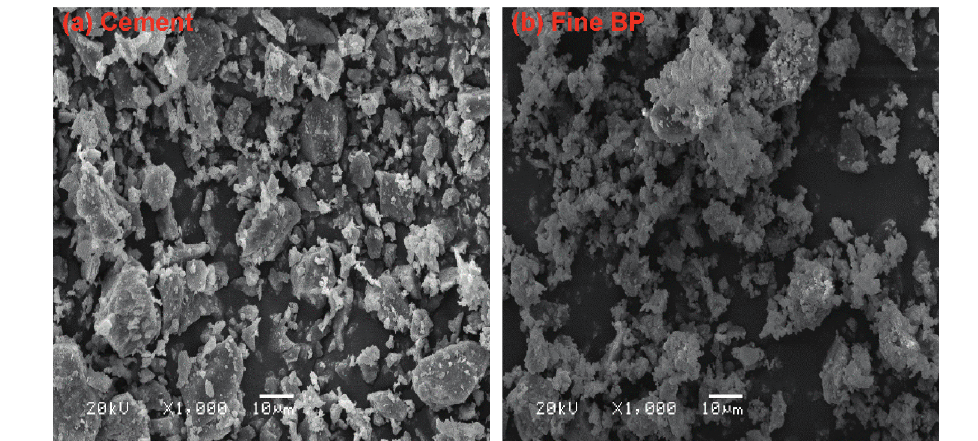
Figure 2: The SEM images of (a) cement and (b) fine brick powder. Table 2: Strength test scheme for cement mortar